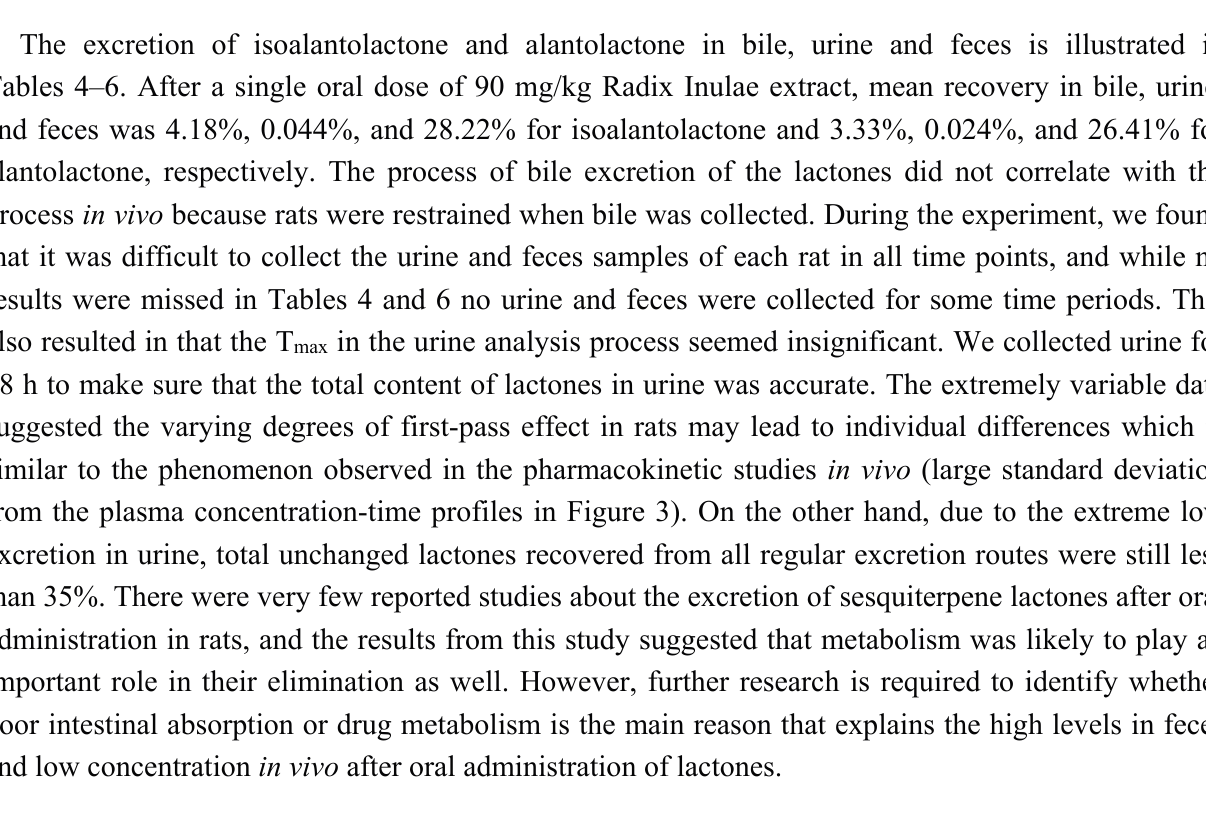
Table 4. Excretion of lactones in rats urine after a single oral administration at 90